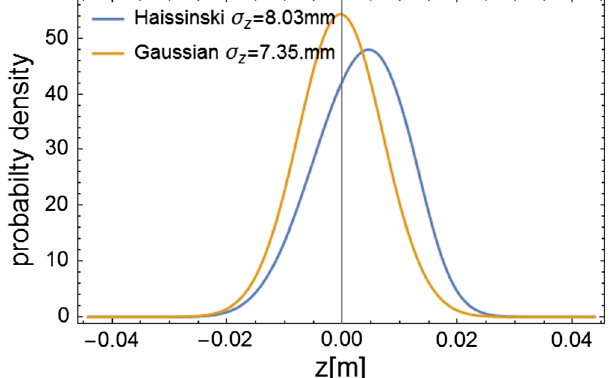
FIG. 2. Comparison of Haissinski distribution of the design population in the CEPC-Z to a Gaussian distribution.